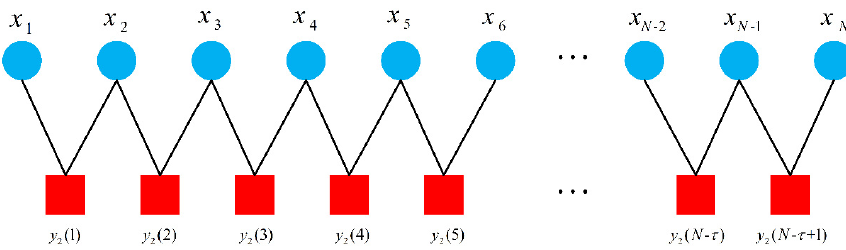
Figure 10. Schematic diagram of the improved multi-scale fuzzy entropy algorithm.